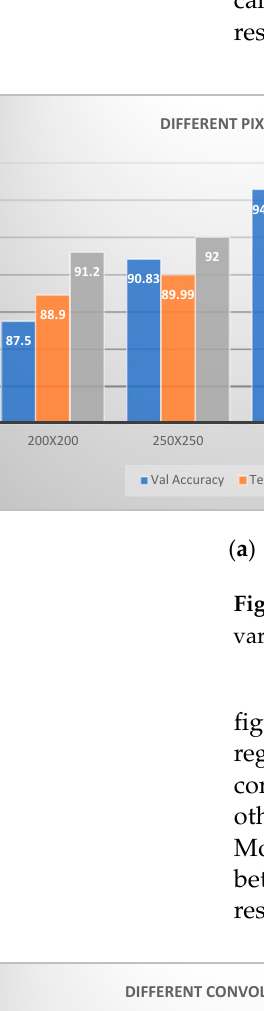
Table 1. Comparison of results of different batch sizes.